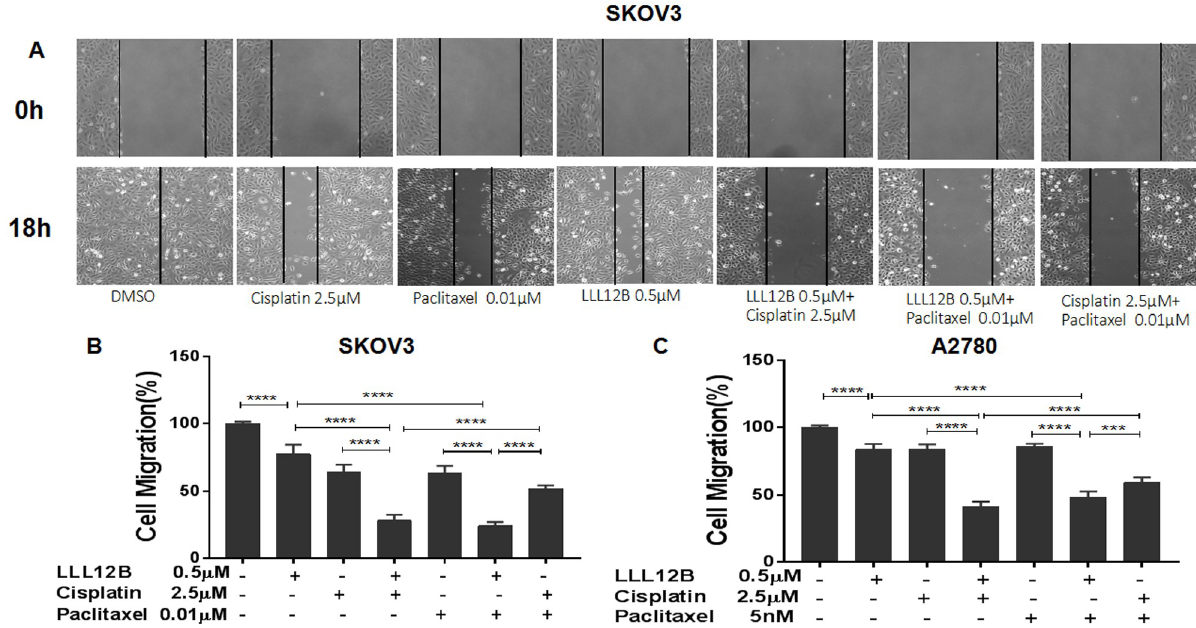
Fig 4. The effects of LLL12B, cisplatin, paclitaxel, and drug combination on cell migration. Wound-healing assays were performed to evaluate the migration ability of SKOV3 and A2780 ovarian cancer cells. SKOV3 and A2780 cells were seeded in 6-well plates and treated with DMSO or different concentration of drugs: LLL12B or cisplatin or paclitaxel or the combination. The differences were found to be significantly different at ��� p < 0.001 and ���� p < 0.0001.